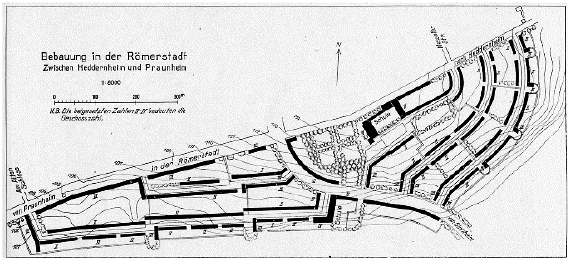
Figure 9. Zeilenbau in Römerstadt. Source: Schürmeyer (1928).